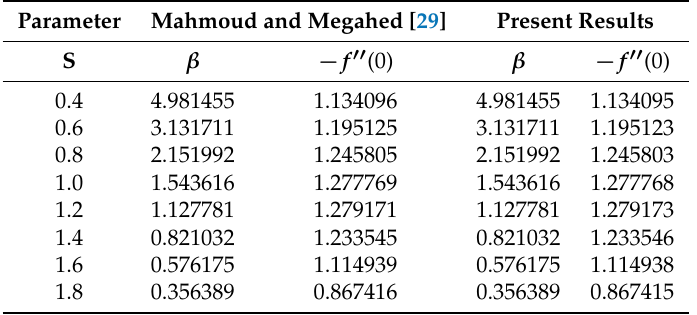
Table 2. Comparison of values of film thickness β and skin friction coefficient f (cid:48)(cid:48) (0) for different values of S when φ = A 3 = A 4 = M = 0, Pr = 10.00, and h = −